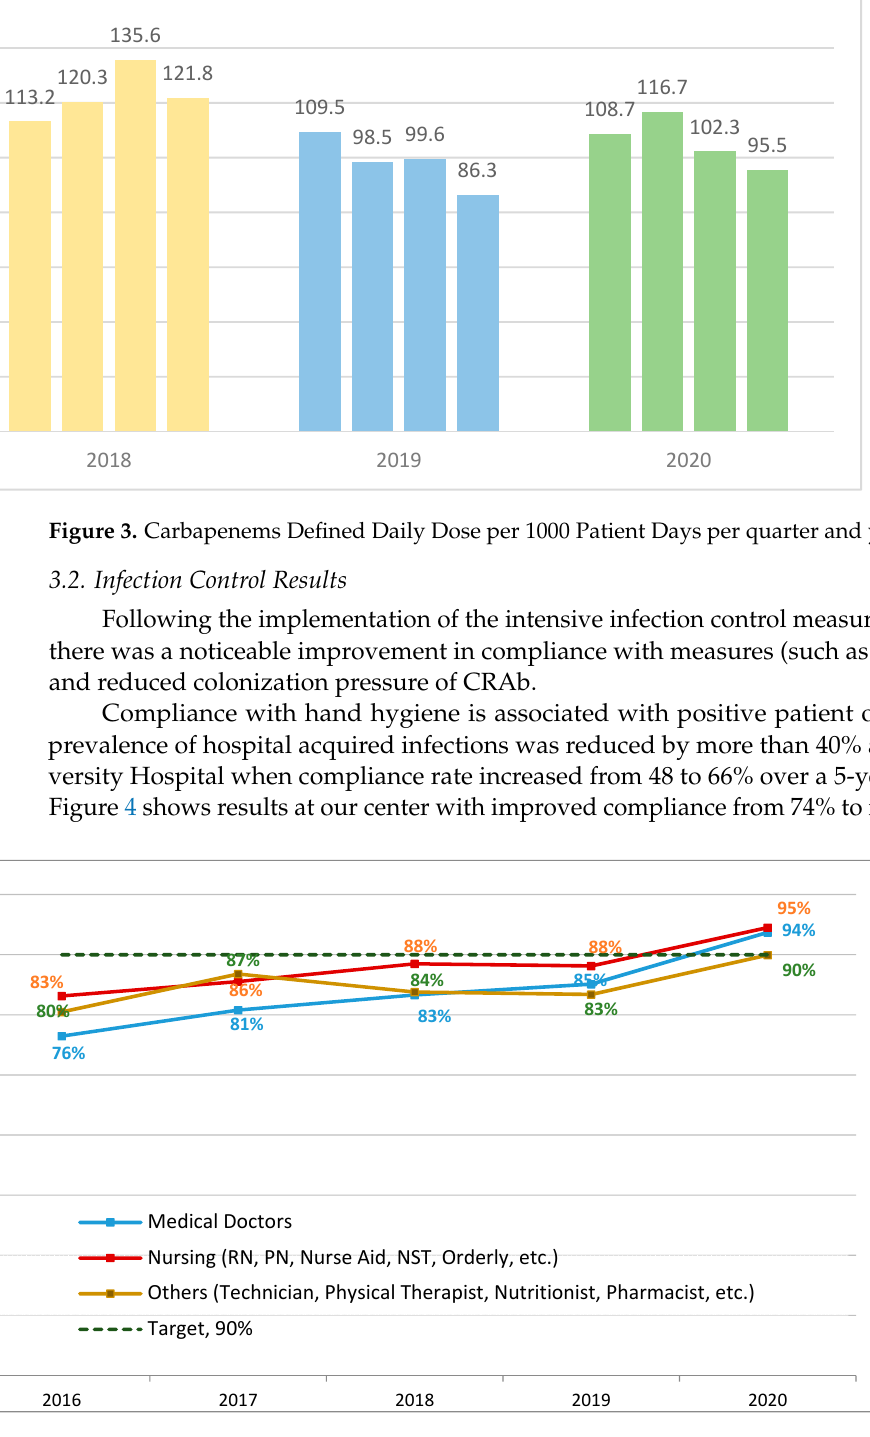
8 of 16 Figure 2. Appropriateness of carbapenem therapy per antimicrobial stewardship team during the implementation of carbapenem sparing strategies (April 2019).